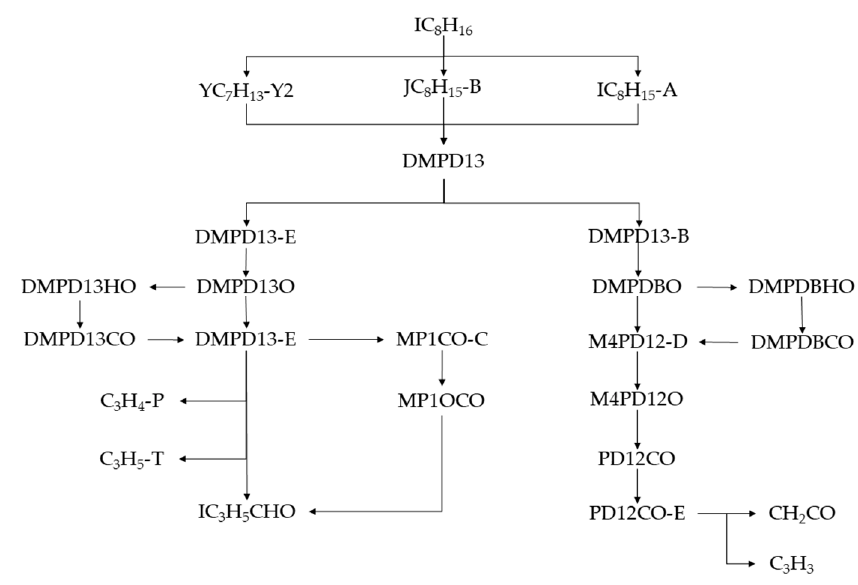
Figure 4. Reaction path of IC 8 H 16 .